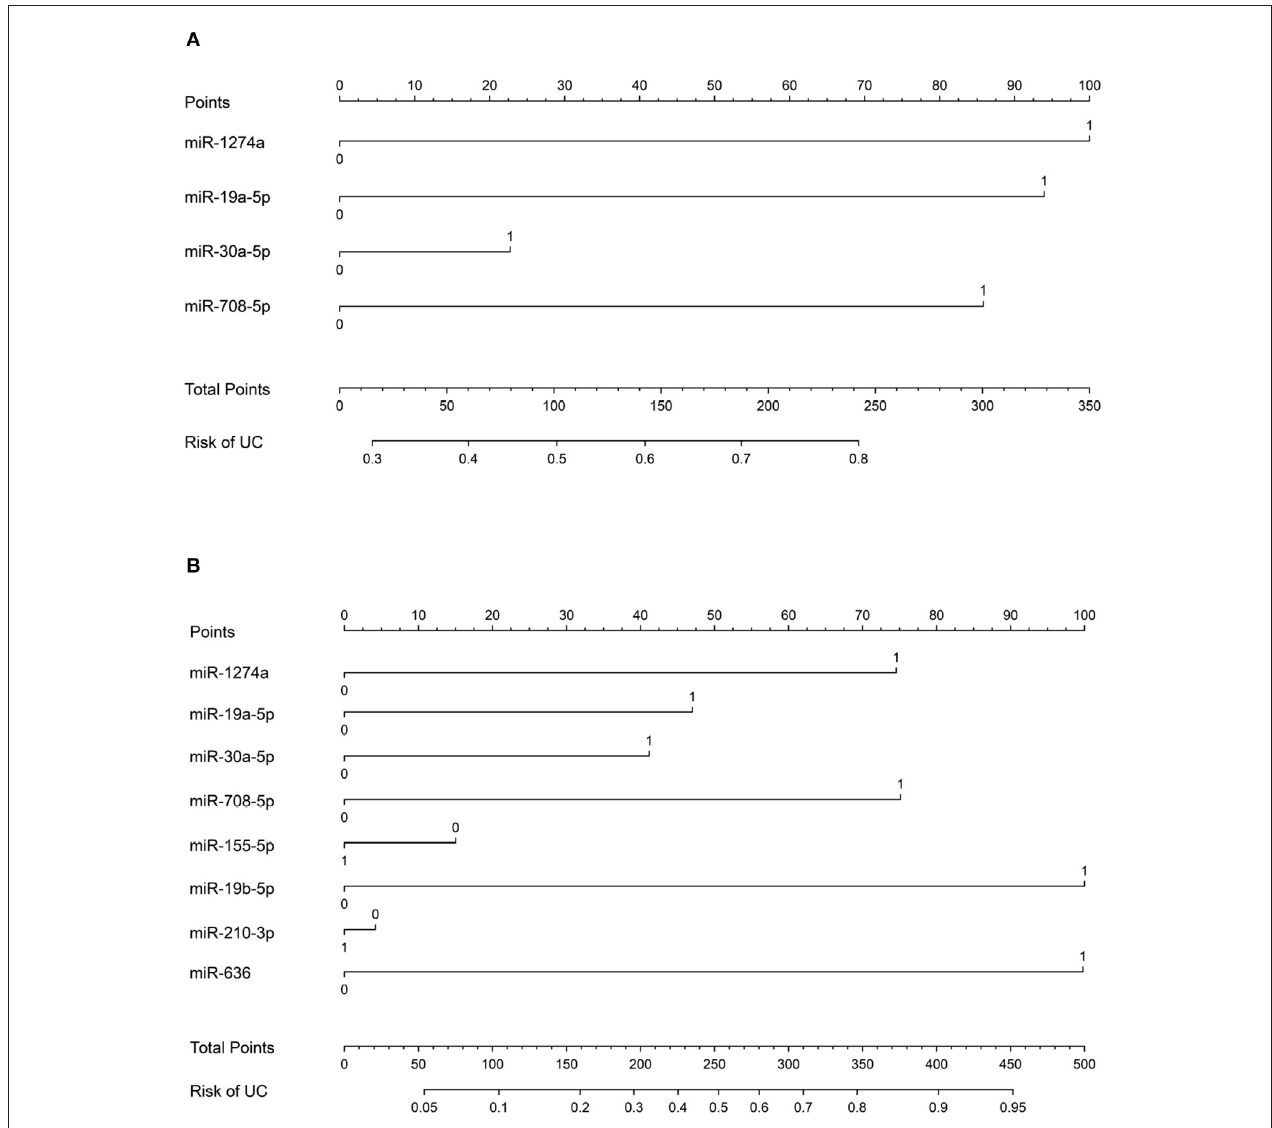
FIGURE 5 | Nomogram for the diagnosis of urothelial cancer. (A) Nomogram plot from the points of four miRNA expressions in urine sample. (B) Nomogram plot from the points of eight miRNA expressions in urine and plasma sample.